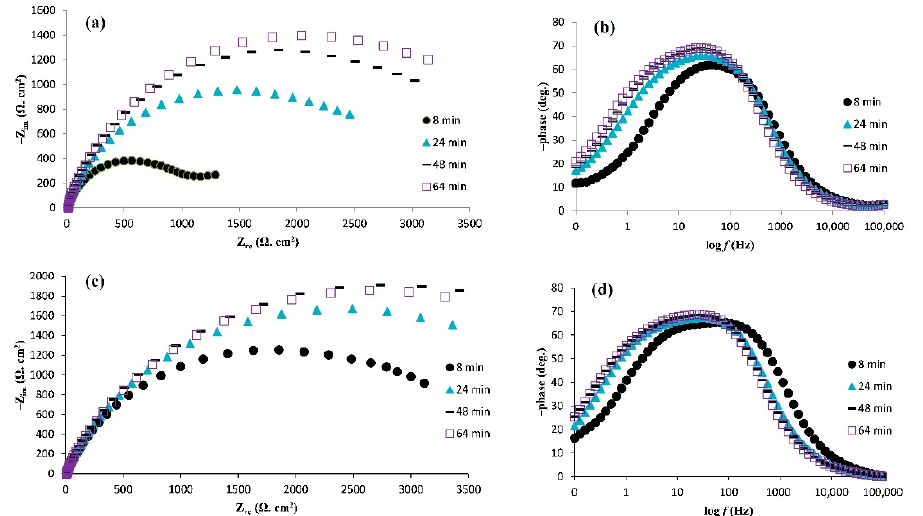
Figure 4. Nyquist and Bode plots of ( a , b ) NiW chloride and ( c , d ) NiW sulfate coatings during 64 min of